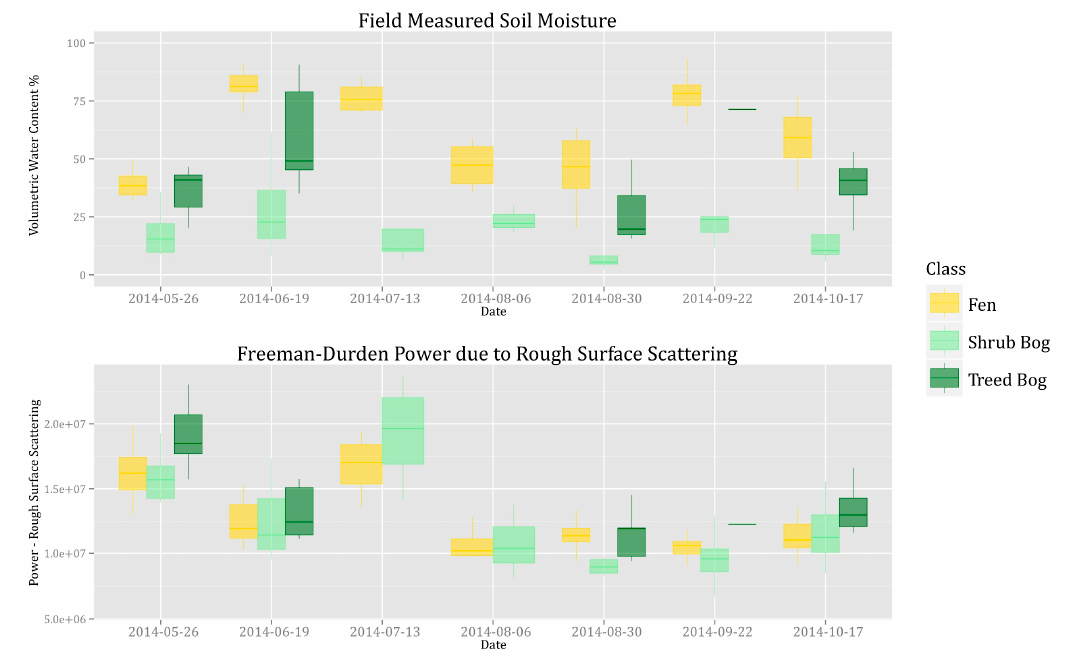
Figure 3. ( Top ) Boxplots of field-measured volumetric water content as measured in 2014, grouped by peatland class and date; ( Bottom ) Boxplots of Freeman-Durden Power due to Rough Surface Scattering (SAR decomposition parameter) extracted at field measurement sites in 2014, grouped by peatland Class and Date.